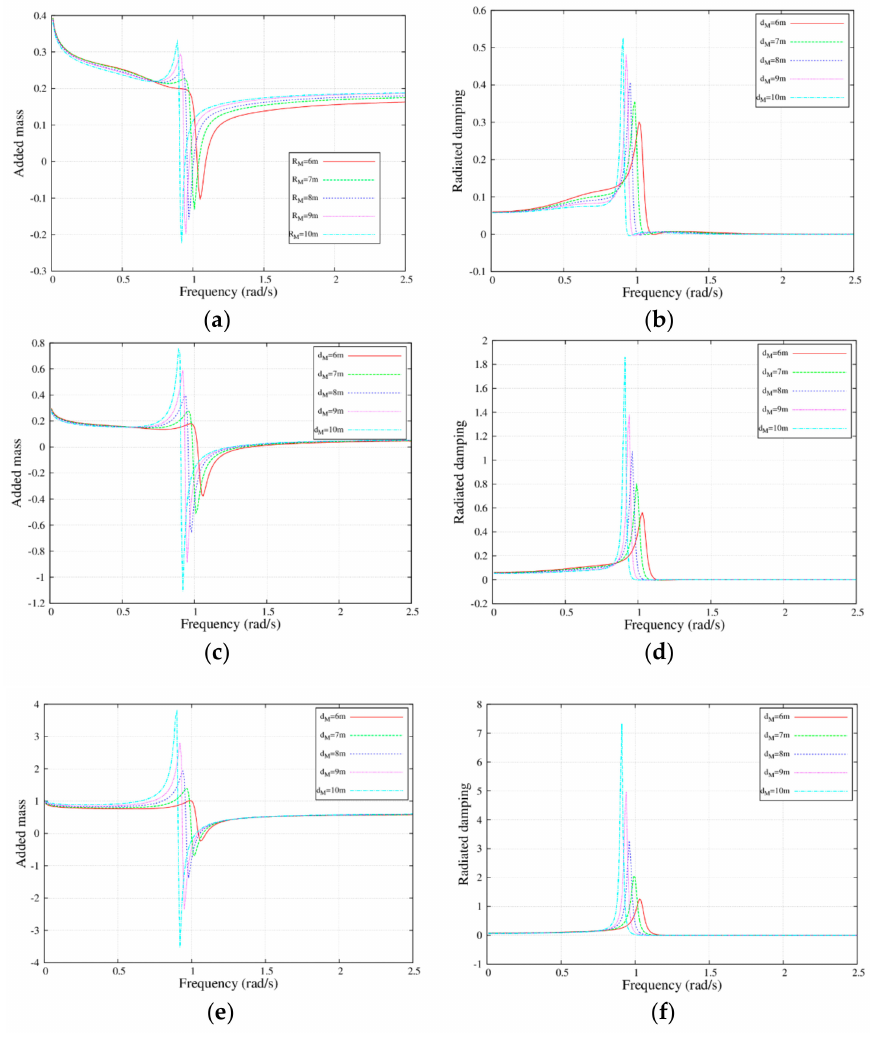
Figure 6. Added mass and damping coe ffi cients with the frequency for MM, MB, and BB with di ff erent draft; d M = 6, 7, 8, 9, and 10 m. ( a ) µ ( d ) λ MB = λ BM , R M = 10 m; ( e ) µ